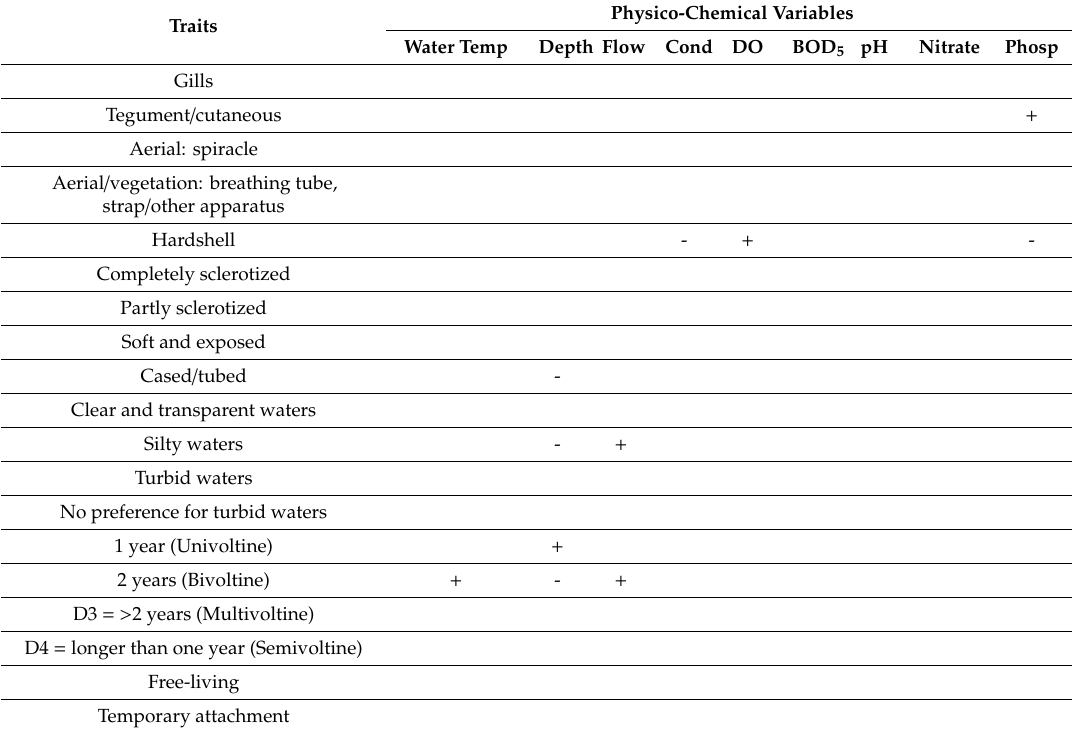
Table 2. Fourth-corner test performed for macroinvertebrate traits and physico-chemical variables in the selected forested riverine systems draining urban landscapes in the present study area. + shows significant positive correlations, and - shows significant negative correlations